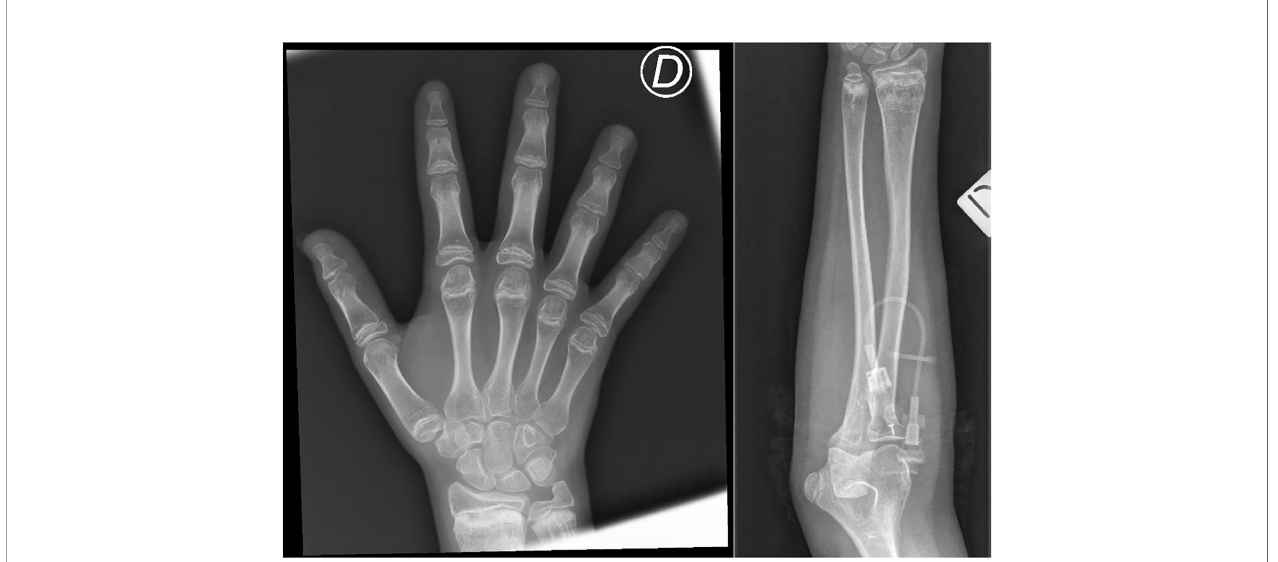
FIGURE 1 | Metaphyseal alterations at the distal radius and ulna, with irregularity of the cartilaginous border and inhomogeneity of the bone structure (areas of marked radiolucency, interspersed among sclerotic striae), and brevity of phalanxes and metacarpal bones. These characteristics are consistent with mild metaphyseal dysplasia in cartilage-hair hypoplasia. D =